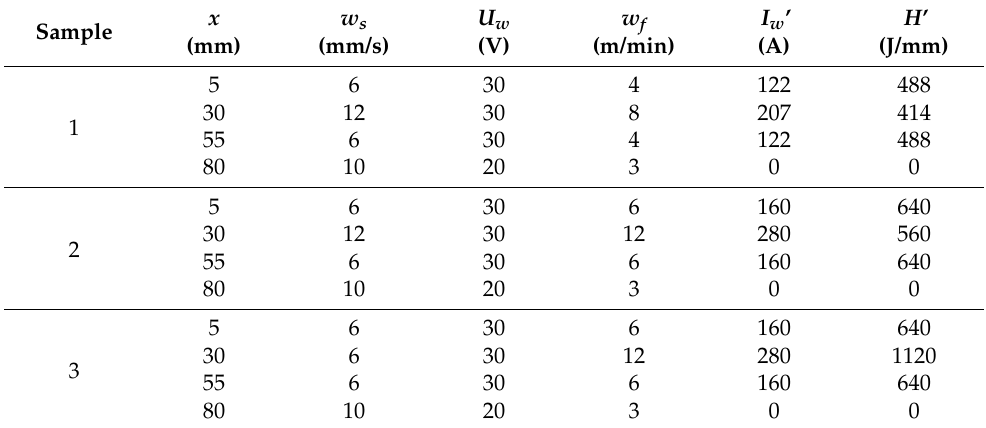
Table 3. Welding parameters used in samples 1, 2, and